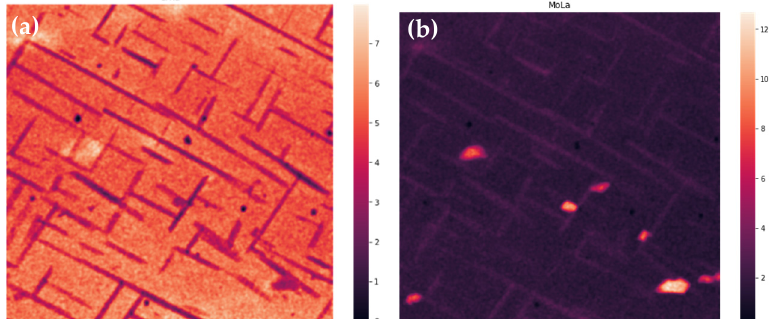
Figure 9. Unwedged and smoothed intensities summed over CrK α ( a ) and MoL α ( b ) peaks. Table 4. Correlation tables for initial ( a ) and final ( b ) set of images. ( a )